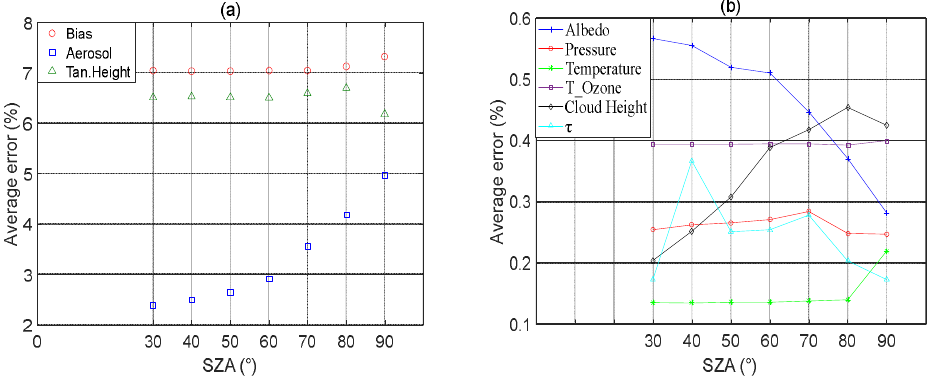
Figure 11. Average errors (%) of retrieved ozone from an altitude between 10 and 70 km at different SZAs, for the same parameters as in Table 1. ( a ) Bias, aerosol and TH; ( b ) albedo, pressure, temperature, ozone absorption cross section, CH and COT.